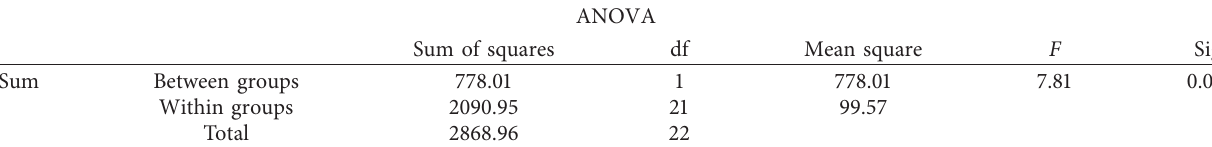
Table 9: ANOVA results for students’ responses based on